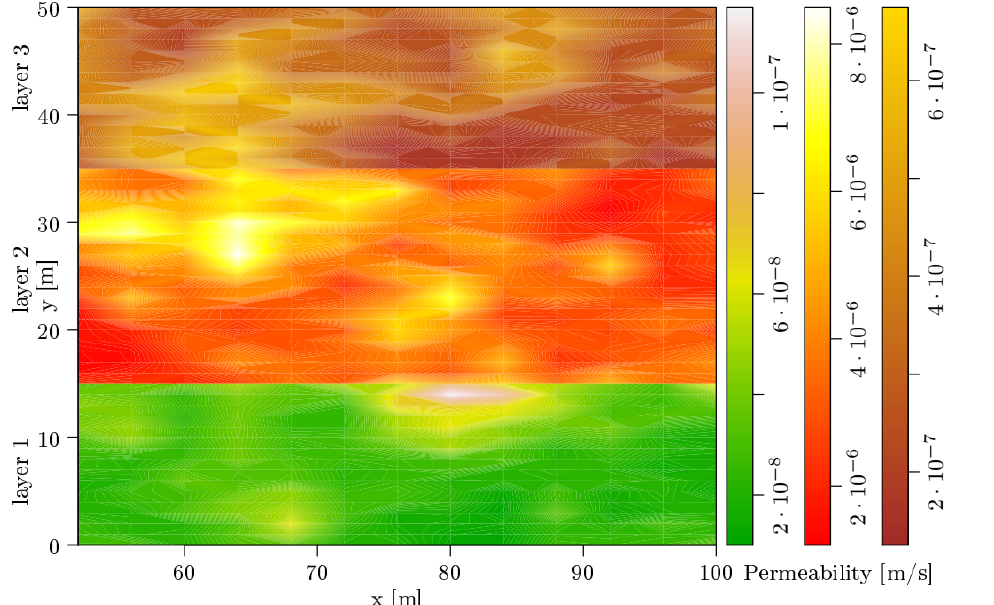
Figure 8. Permeability as realization of the three Log-Gaussian random fields for the three layers (here: a 50 meters section of the modelled soil). The colors represent the realized permeability values (cf. color legend).